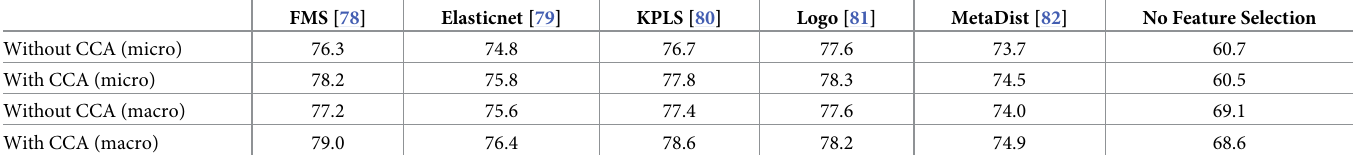
Table 3. Average accuracies (micro- and macro-) of the classification of dementia with and without CCA features. Columns refer to different feature selection methods. FMS [78] Elasticnet [79] KPLS [80] Logo [81] MetaDist [82] No Feature Selection Without CCA (micro) 76.3 74.8 76.7 77.6 73.7 60.7 With CCA (micro) 78.2 75.8 Without CCA (macro) 77.2 With CCA